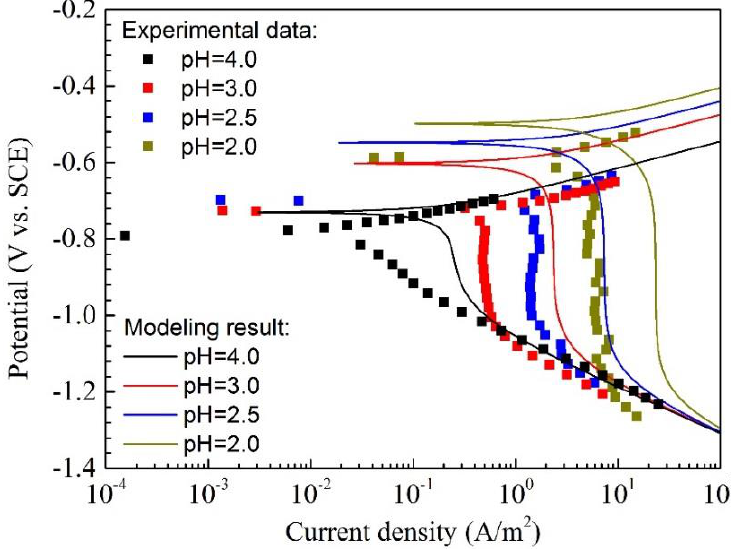
Figure 8. The polarization curves and modeling results of Q345R steel in 1 wt.% NaCl solution containing 0.08 mg/L oxygen with different low pH at 30 ◦ C. Square: experimental data. Solid line: modeling